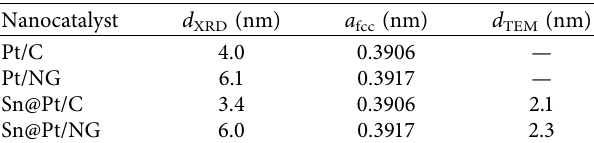
Figure 1: XRD patterns of Pt/C, Sn@Pt/C, Pt/NG, and Sn@Pt/NG. Table 1: Parameters of the nanocatalysts from XRD and TEM analysis.